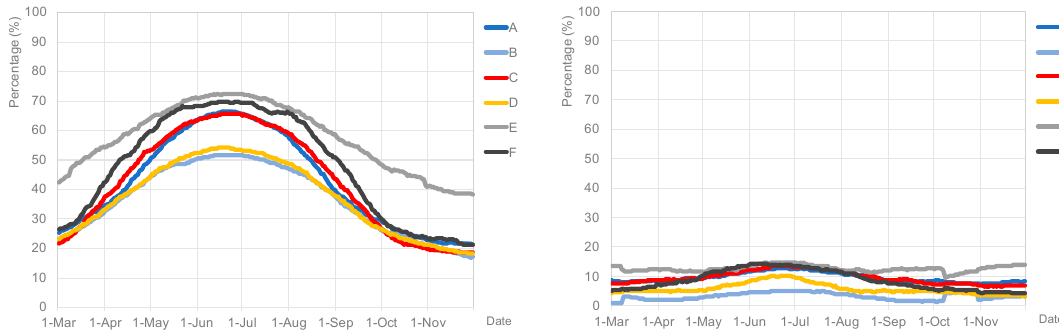
Figure 11. Percentages of ground-level surface with direct sunlight for three or more hours ( left ) and six or more hours ( right ) from March to November for study sites A to F when FAR is 4.0.